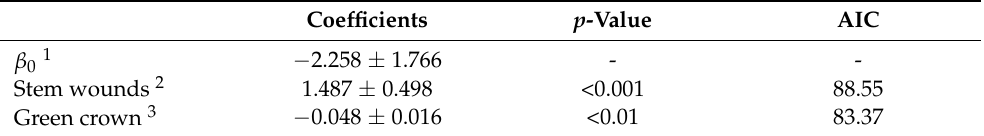
Table 6. Generalized linear model (GLM) showing the variables influencing the presence of ambrosia beetle attacks in unburned cork oaks in three forest stands (variables are ordered by decreasing order of importance; model based on 210